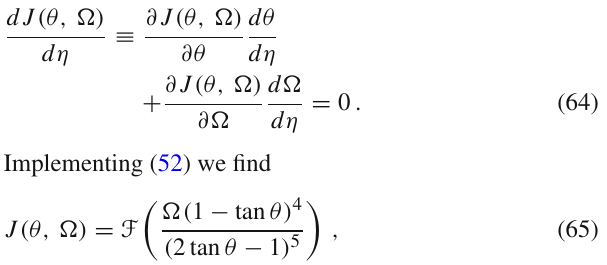
Fig. 1 Phase trajectories on the compactified R - (cid:11) plane with θ = tan − 1 ( 1 / 2 ) , which corresponds to the y = 2 z submanifold, i.e. the R 2 regime,for (a) w = − 1, (b) w = 0, (c) w = 1.Inthislimittheequations ofstatefor(modified)BerthelotandDietricifluidsreducetothatofpres- sureless dust, so that they correspond to only figure (b) . The equation of state for the Redlich–Kwong fluid in this limit reduces to p = − βρ , so